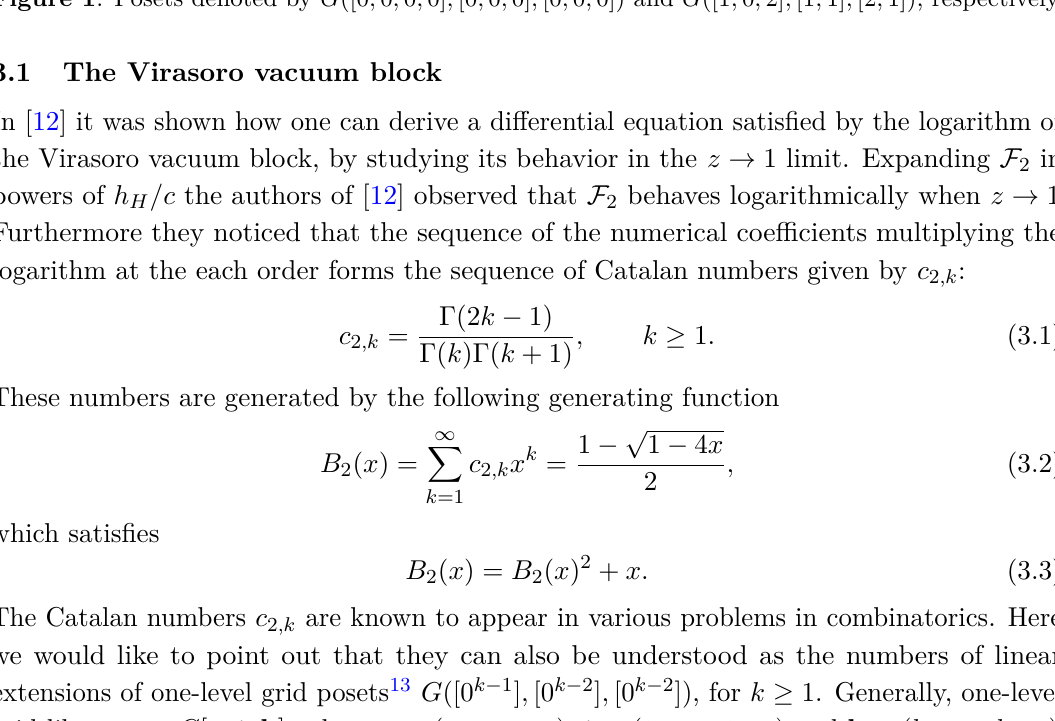
Figure 1 . Posets denoted by G ([0 , 0 , 0 , 0] , [0 , 0 , 0] , [0 , 0 , 0]) and G ([1 , 0 , 2] , [1 , 1] , [2 , 1]) ,